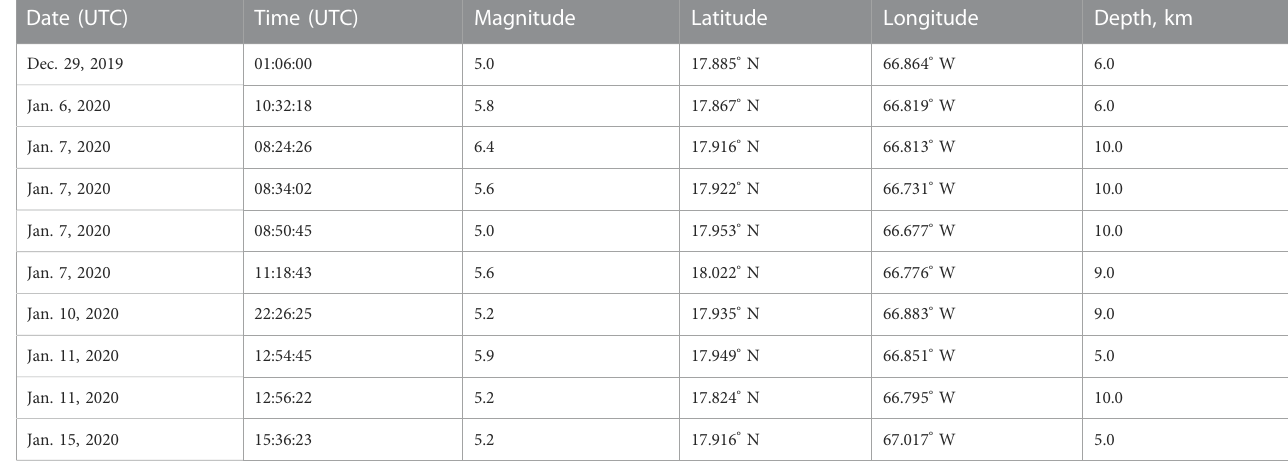
TABLE 1 Summary of magnitude fi ve and larger earthquakes between December 29th, 2019 – 17 January 2020 (Van Der Elst et al.,